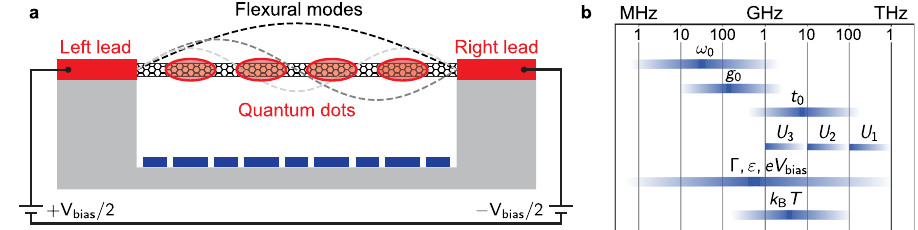
Fig. 1 Setup and tuning range of parameters. a Schematic picture of the system. A suspended nanotube hosts four spin-polarized quantum dots. The back gates control the local chemical potential and hoppings between dots. The short separation between the nanotube and gates allows one to reach a very large electron-phonon coupling strength. The whole system couples to the left and right leads controlled by a bias voltage V bias . b The typical tuning range of different parameters. Here the fundamental frequency ω 0 is divided by 2 π , and other parameters are divided by 2 π ℏ